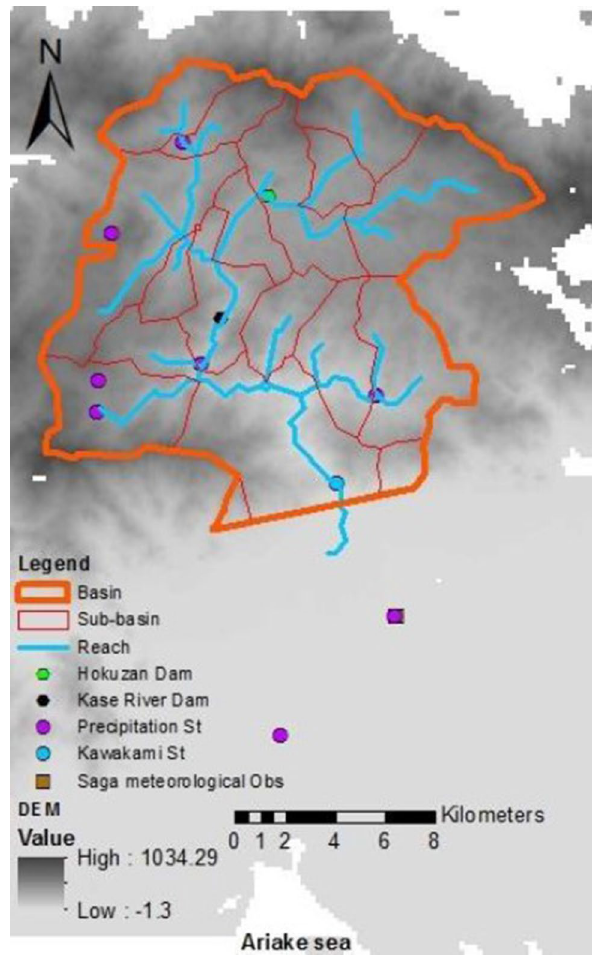
Fig. 2 Hydrological and meteorological